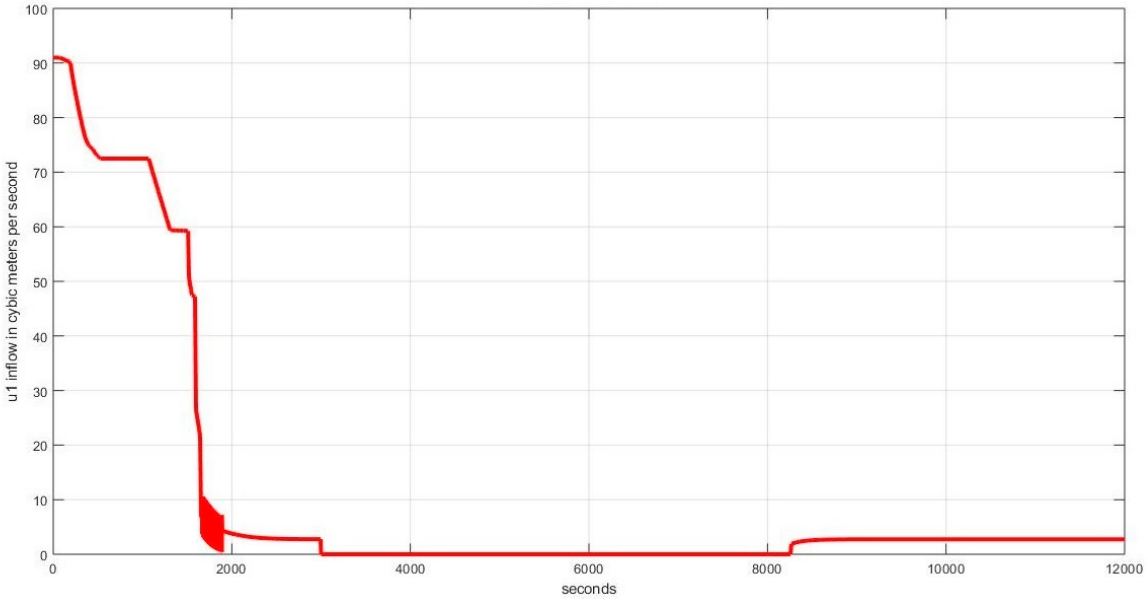
Figure 27. U1 control variable indicating the water inflow in case of a positive surge.